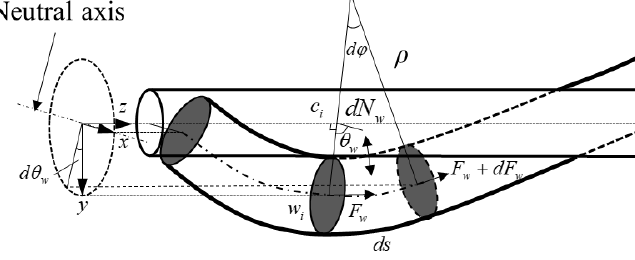
Figure 15. The schematic of mechanic model for each wire in the strand.